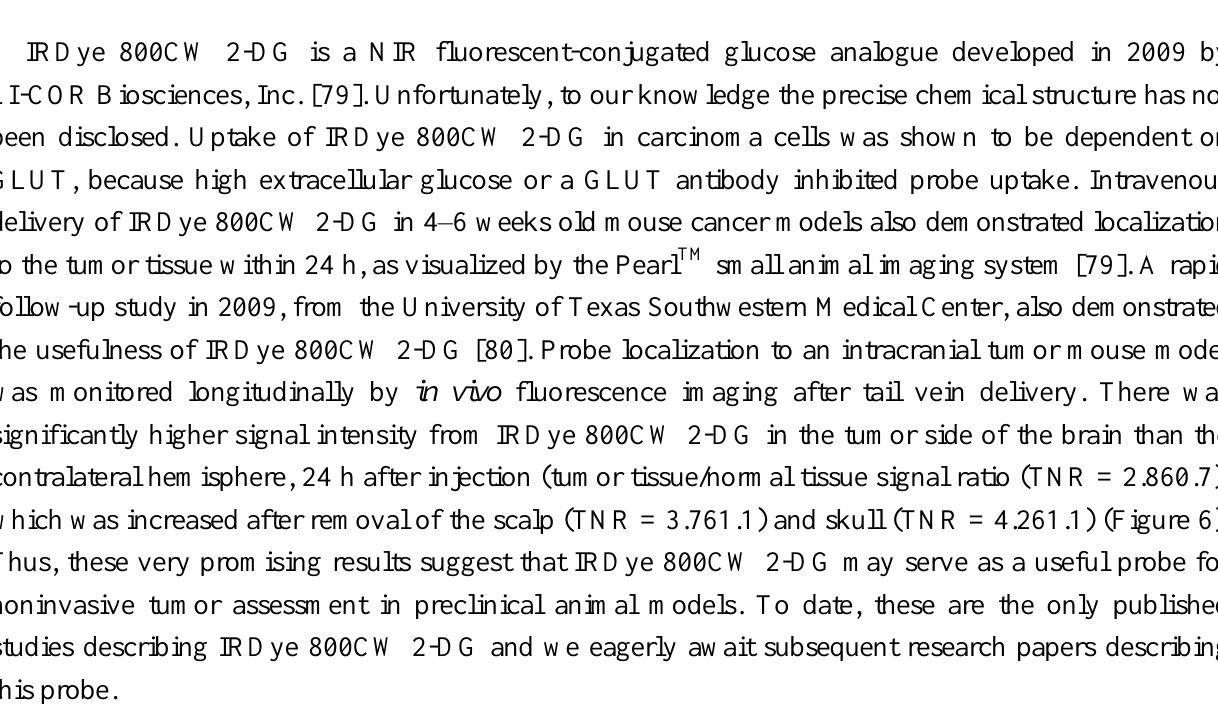
Figure 6. Imaging IRDye 800CW 2-DG uptake in a mouse model of intracranial